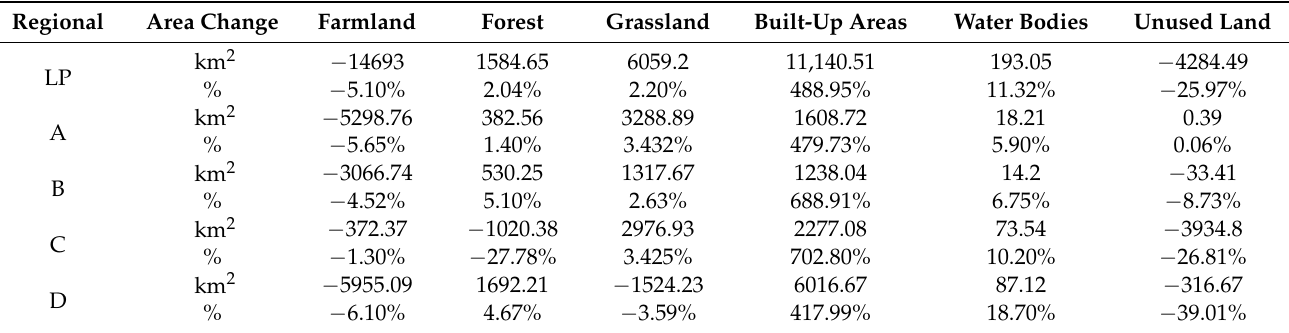
Table 5. Pearson correlation coefficient between RSEI and vegetation index for the Loess Plateau.